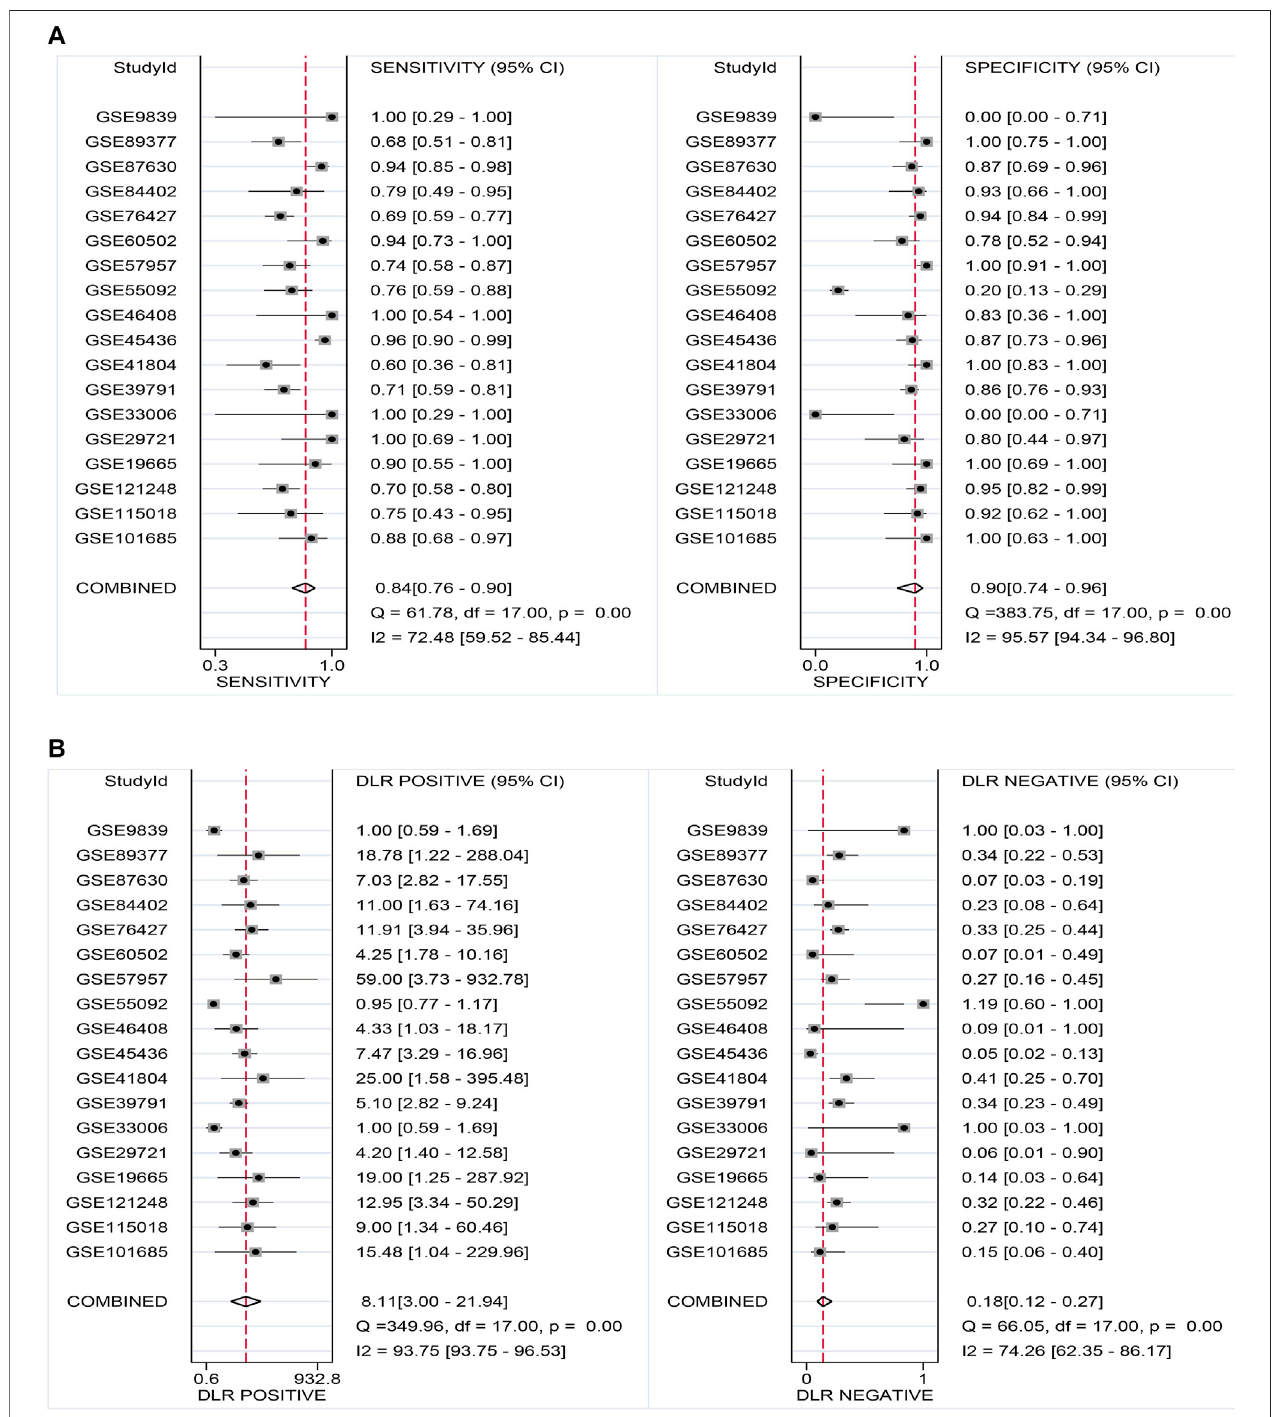
FIGURE6 | Sensitivityand speci fi cityas well asDLR positive and DLR negative. (A) Sensitivity and speci fi city values ofincluded studies. (B) DLR positive and DLR negative of included studies.